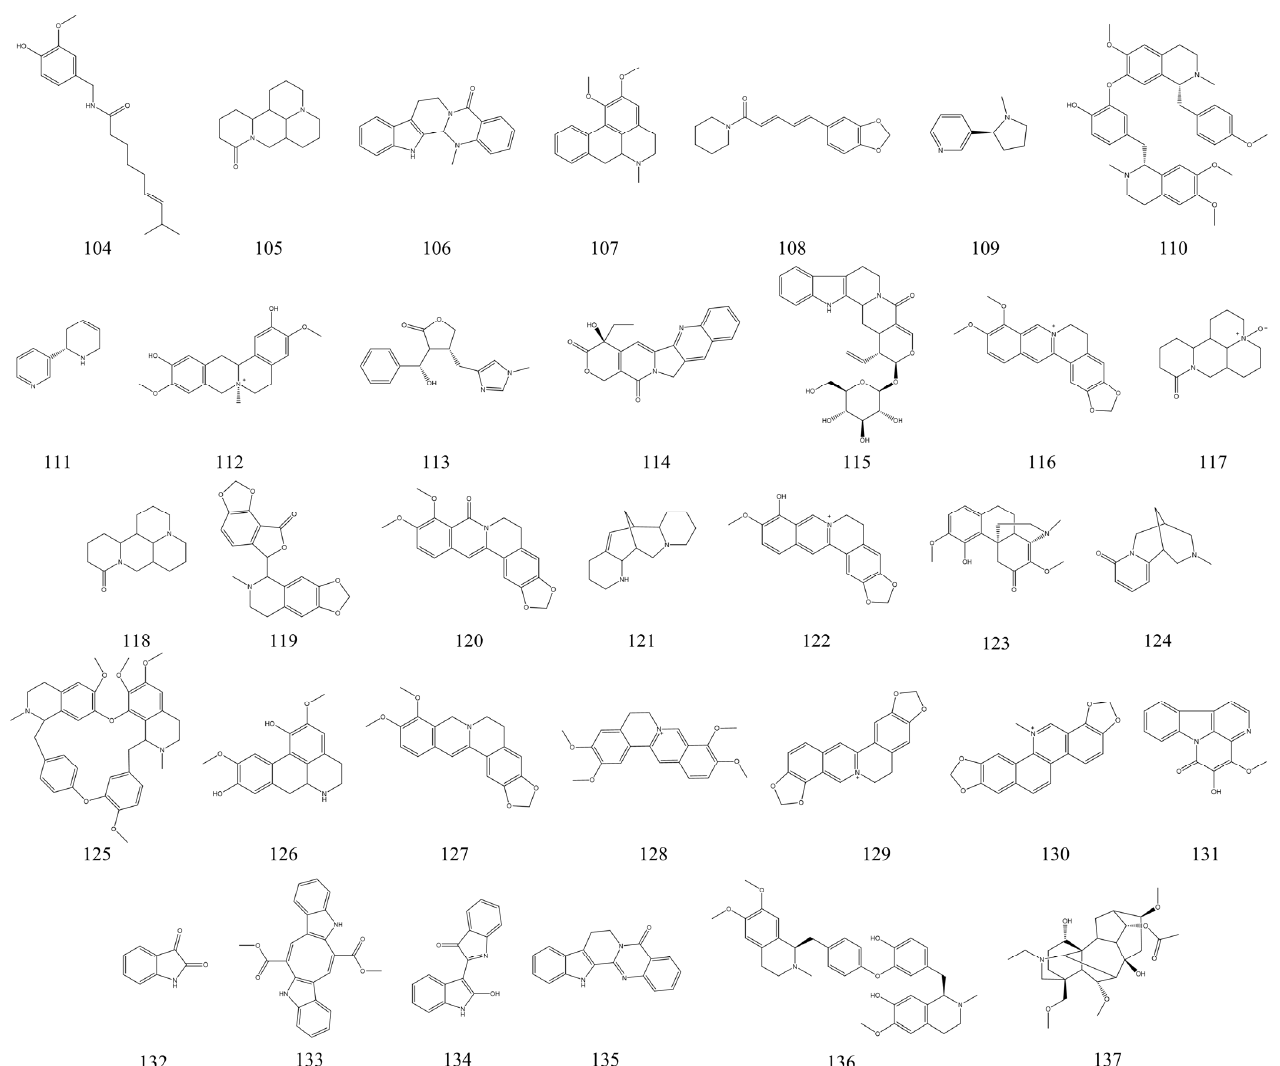
Figure 9. Structural formulae of alkaloids with IBD therapeutic effects.